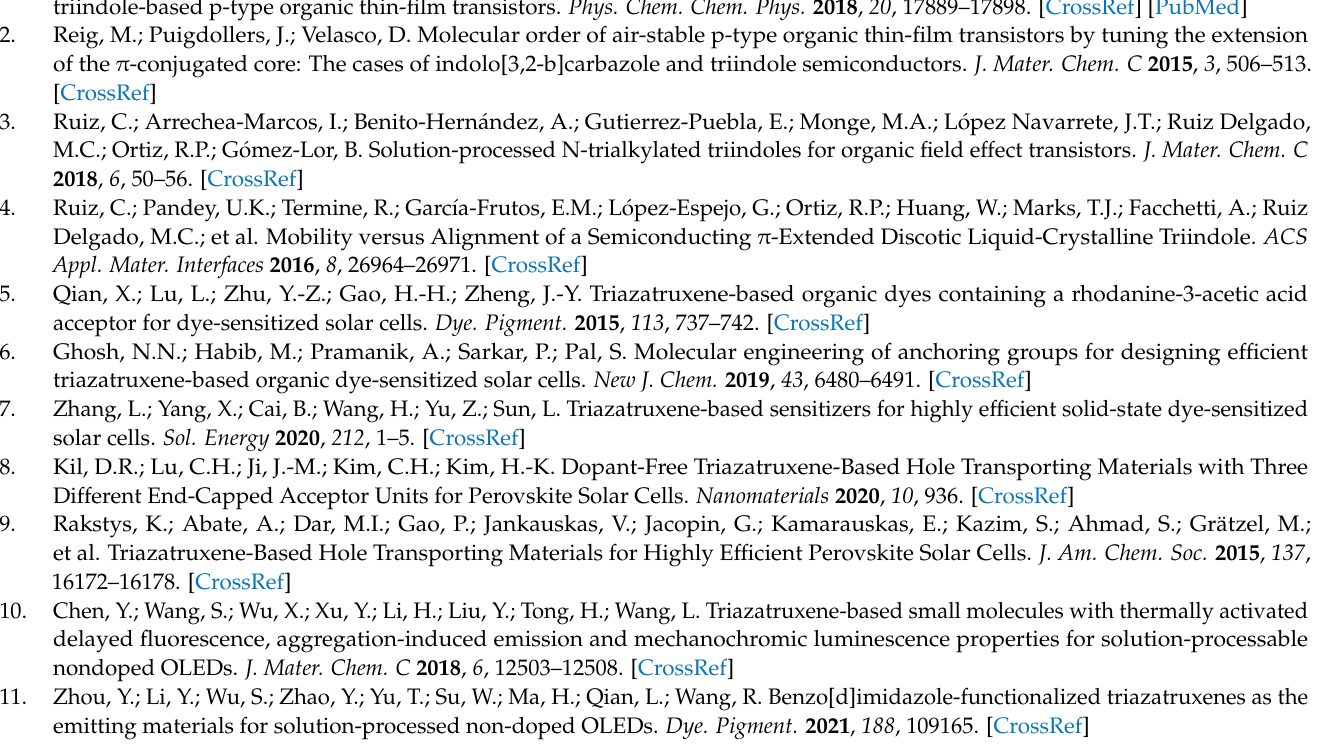
structure for the fully relaxed (twisted) and constrained (planar) geometries of triindole 1 and energy differences between the fully relaxed (twisted) and constrained (planar) geometries of triindoles 1 – 3 ; Figure S8: DFT-computed global minimum structures for a trimer model of 1 and 2 ; Figures S9 and S10: DFT-calculated dihedral angles values along the conjugated backbone for the triindoles 1 – 3 on their neutral and radical cation states; Figure S11: DFT-estimates of the transfer integrals for holes for model cofacial dimers of 1 – 3 systems; Table S1: Main crystallographic and refinement data for 2 ; Tables S2–S4: OFET derived electrical data for 1 – 3 vapor-deposited films under different conditions.; Figures S12 and S13: Experimental GIXRD spectra of triindoles 2 and 3 deposited by slow